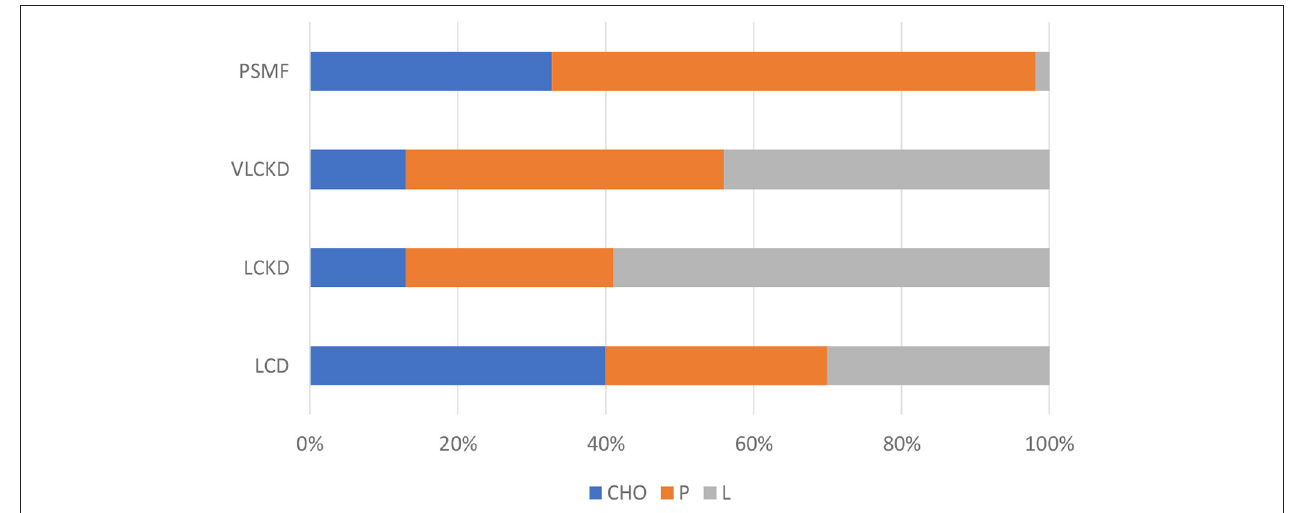
FIGURE 1 | Approximate macronutrient percentage in low calorie